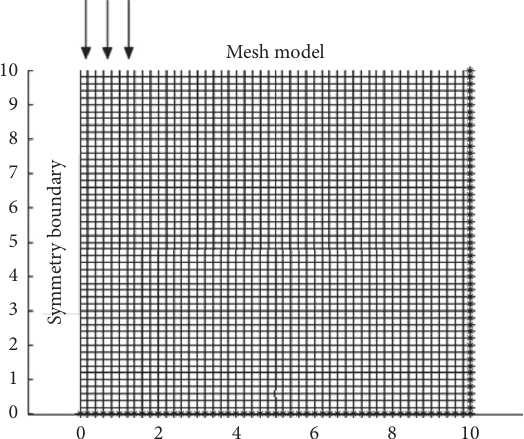
Figure 6: Modeling and mesh discretization for example